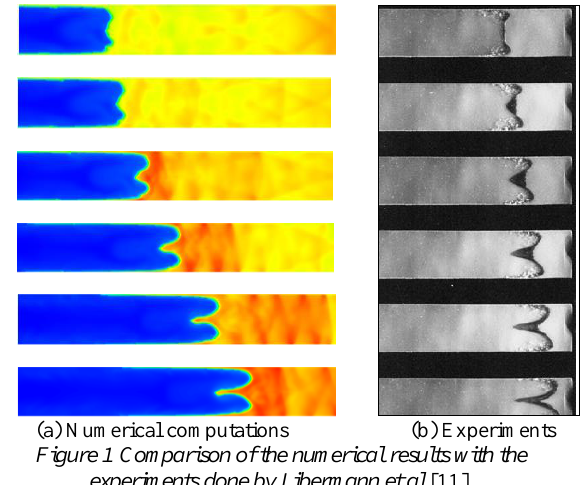
Figure 1 Comparison of the numerical results with the experiments done by Libermann et al [11].